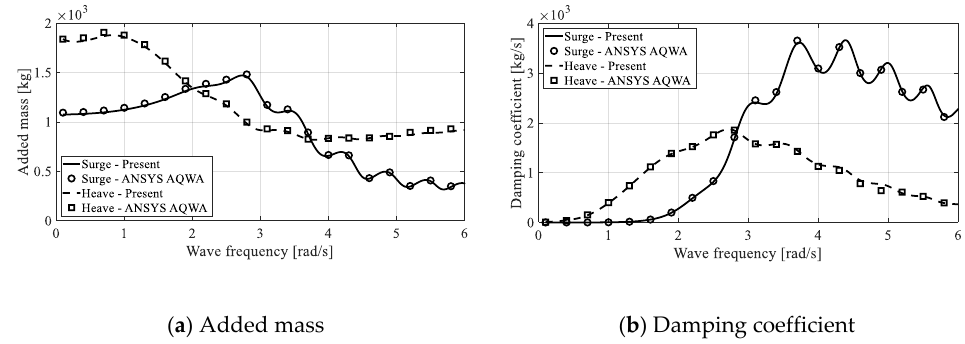
Figure 13. Comparison of the added mass and radiation damping coefficients of the float at Chilbaldo.